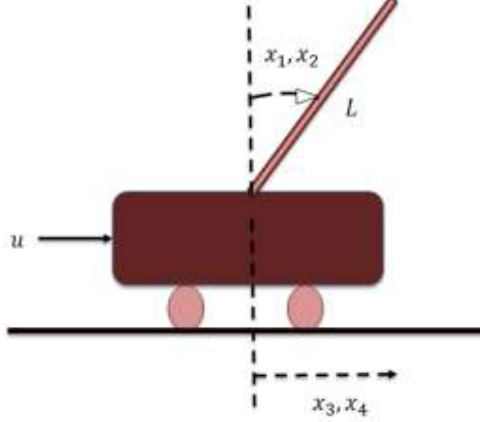
Figure 3. The inverted pendulum on a movable cart.